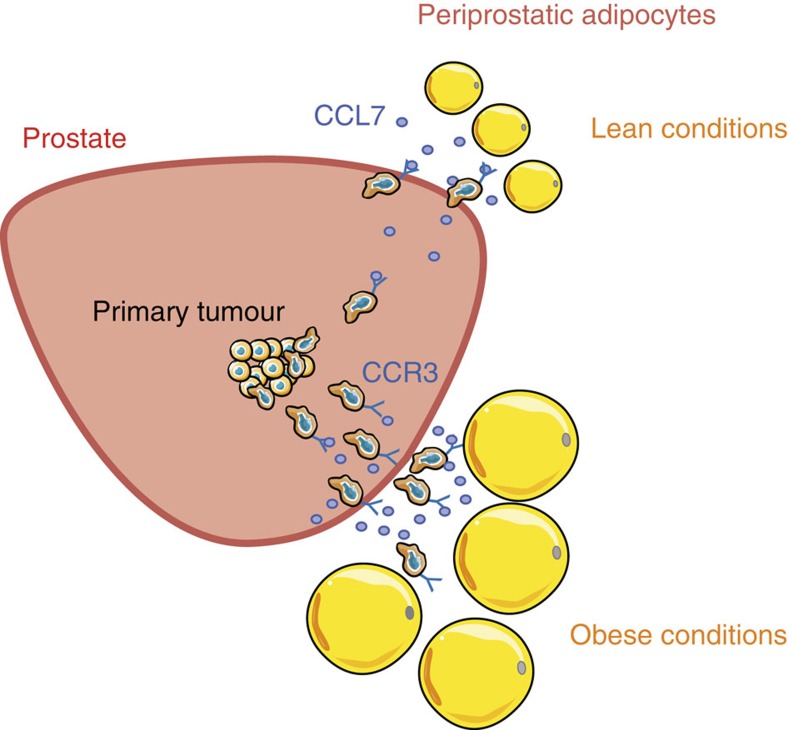
Schematic representation of the proposed role of PPAT in the local dissemination of prostate cancer and its amplification in obesity.Mature adipocytes secrete the chemokine CCL7, which diffuses through the capsule to the peripheral zone of the prostate. The interaction between CCL7 and the CCR3 receptor, expressed by invasive tumour cells, promote their migration outside of the prostate gland. Hypertrophic adipocytes secrete larger amounts of CCL7, which increases adipocyte-dependent directed migration facilitating extraprostatic extension in obesity.